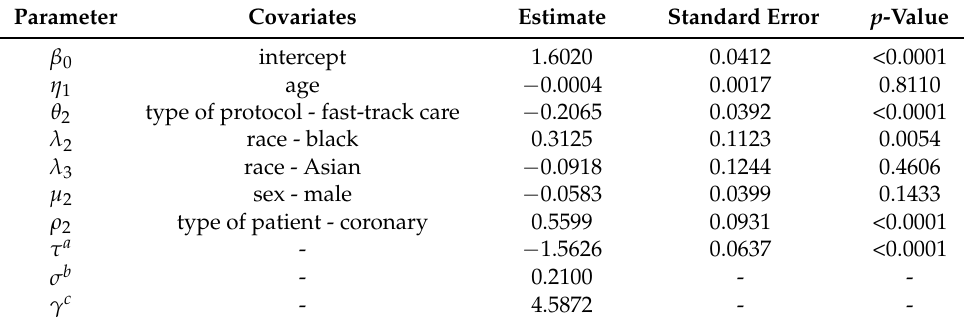
Figure 5. Kaplan–Meier curves S ( t ) (shading shows 95% CIs) with log-rank test, C-index, and risk tables for the variables: gender ( a ), race ( b ), type of patient ( c ), and type of protocol ( d ). Table 4. Weibull regression model parameter estimates (full